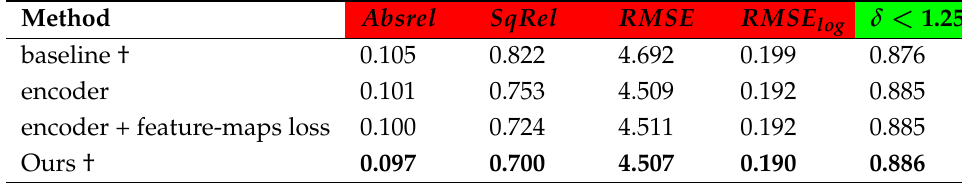
Table 4. The ablation study of different combinations. †, using post processing